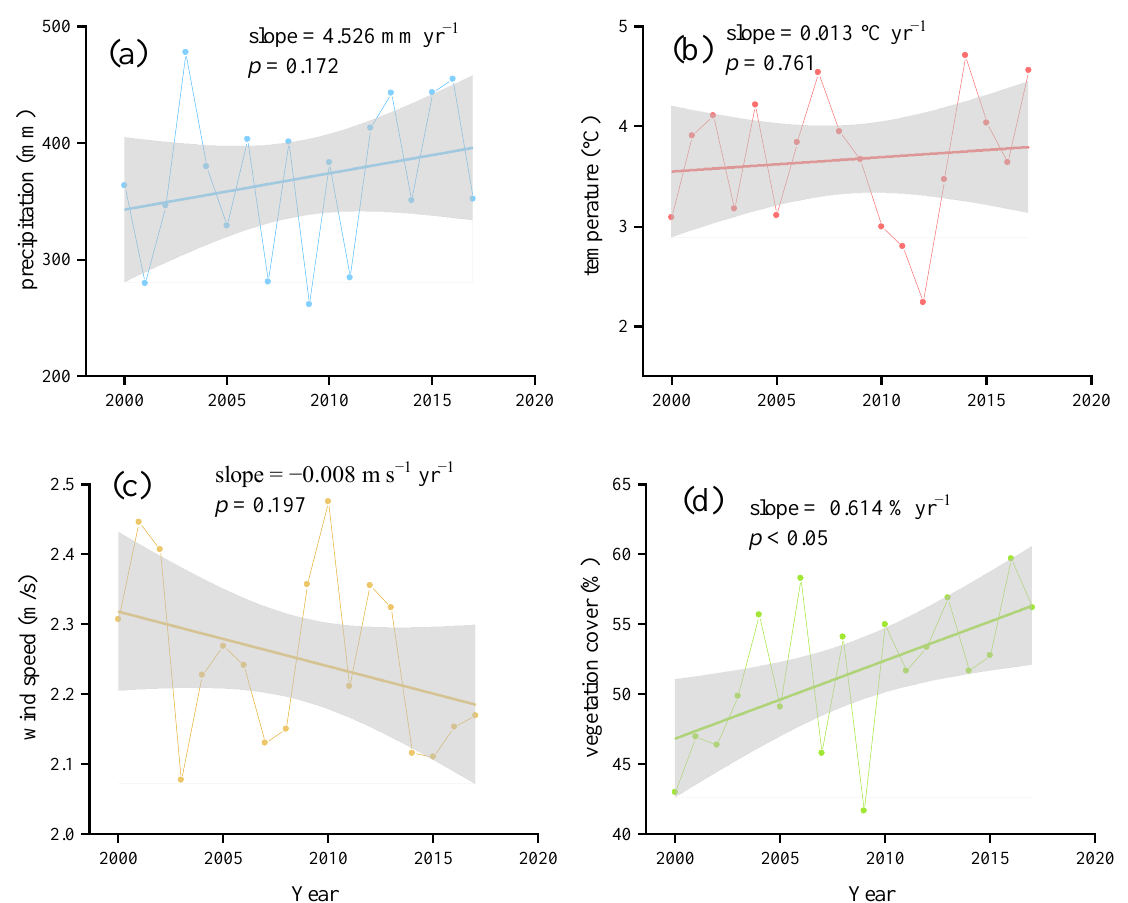
Figure 2. Temporal variation in the annual ( a ) precipitation, ( b ) mean temperature, ( c ) mean wind speed and ( d ) vegetation cover in Duolun County during 2000–2017. The gray areas represent the 95% confidence intervals.